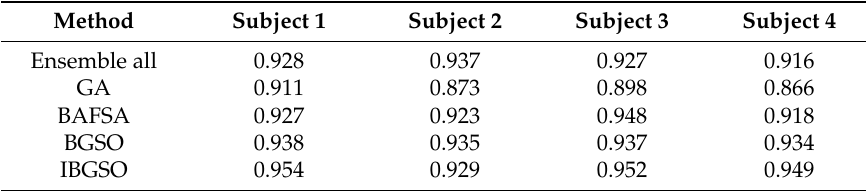
Table 7. F1 comparison of the four subjects for the five approaches using the OPPORTUNITY dataset.